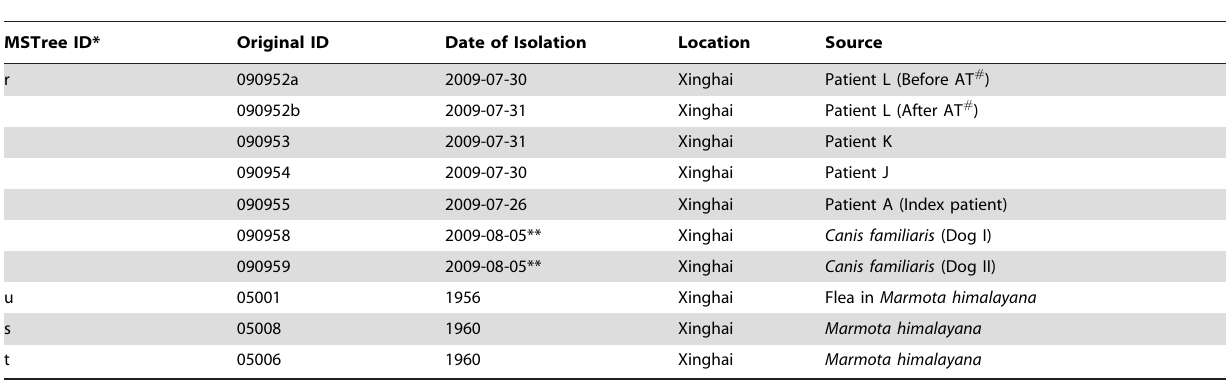
*: MSTree ID refers to the strain ID in Figure 3A. # : AT stands for antibiotic treatment. **: The two dogs that died in the outbreak were buried on July 22 and 23, 2009, respectively [31]. For the epidemic investigation, the bodies were exhumed, and strains 090958 and 090959 were successfully isolated from the necropsy samples on August 5,